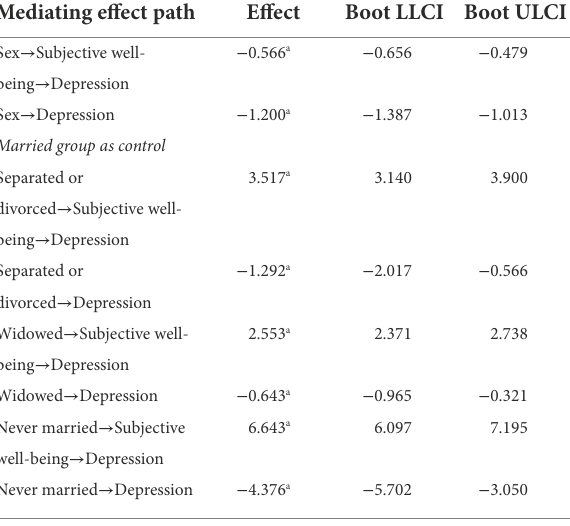
TABLE 5 The mediating effects test of subjective well-being (direct and indirect